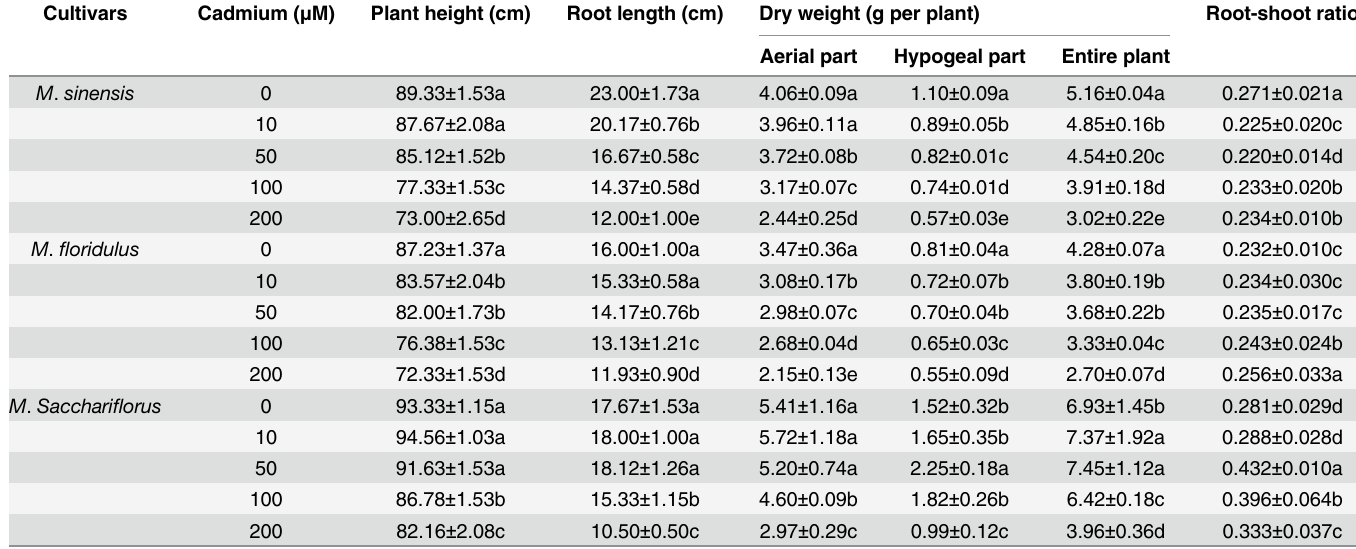
Table 1. Growth and dry weight of three Miscanthus species in response to Cd stress for 16 days. Values represent mean ± SD (n = 4). Differences letters indicate significant differences (P < 0.05) between Cd levels. Cultivars